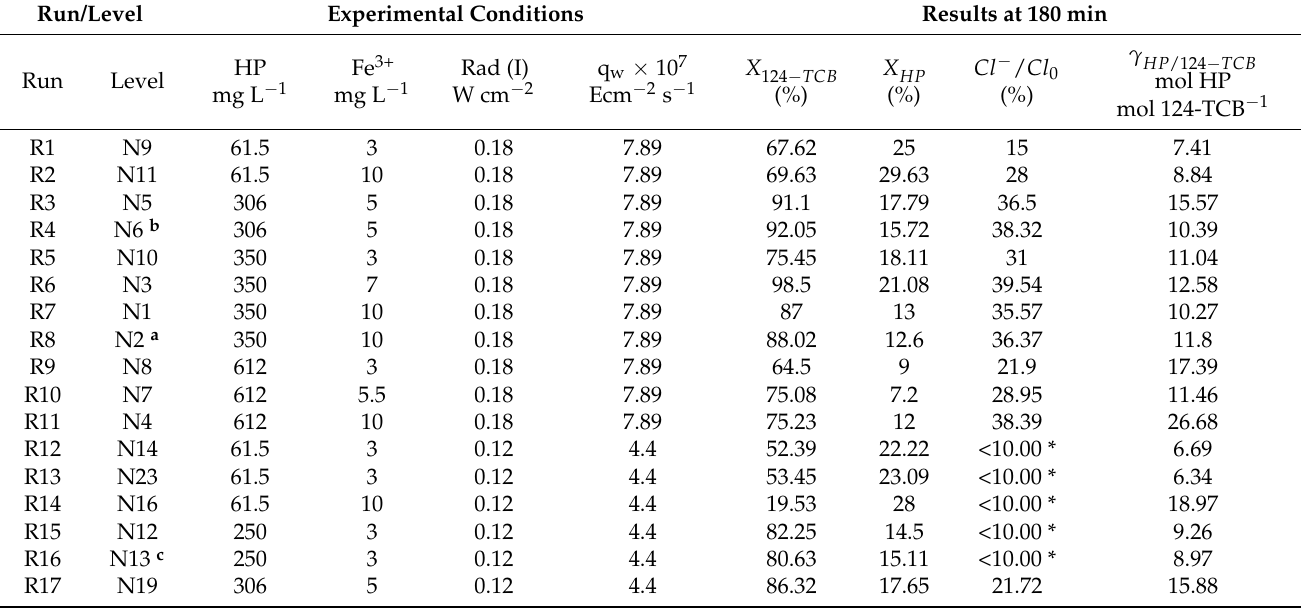
Table 1. Run conditions using D-Optimal experimental design for two independent variables, HP and Fe 3+ at Low (I = 0.12 W cm − 2 ) and High (I = 0.12 W cm − 2 ) Rad conditions; X 180 min response. Molar ratio Fe 3+ :Oxalate = 1:10. Results at 180 min for 124-TCB and HP conversions ( X 180 min and X 180 min ). Dechlorination ( Cl − / Cl 0180 min ) and specific consumption of the oxidant HP 124 − TCB ( γ 180 min ) are also shown. (Molecular weights: 124TCB = 184.45 g molg − 1 , H 2 O 2 = 34 g molg − 1 , HP /124 − TCB and Fe = 55.84 g molg − 1 ).